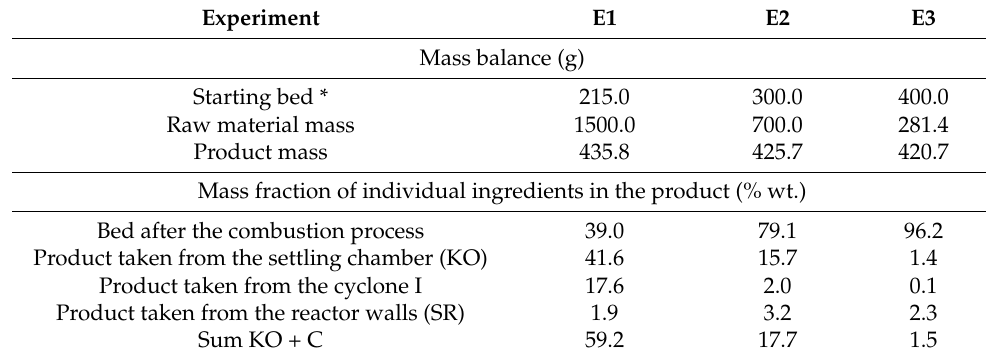
Table 4. Mass balance of poultry manure combustion in the fluidised bed